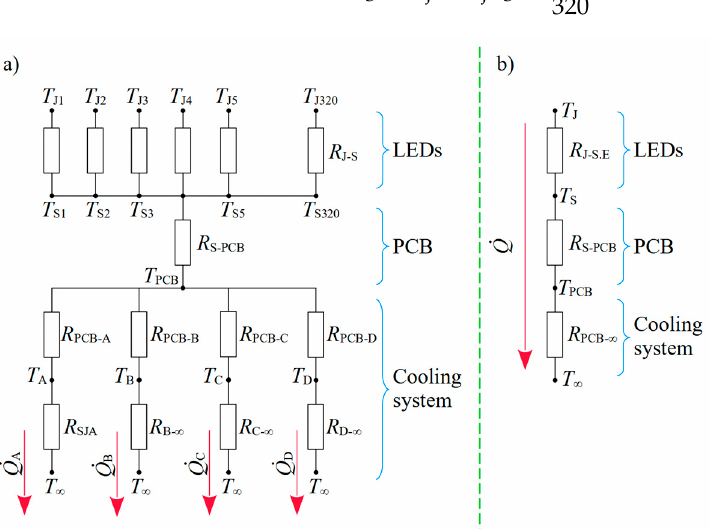
Figure 13. The thermal resistance network of the LED lamp: ( a ) complete and ( b ) equivalent.